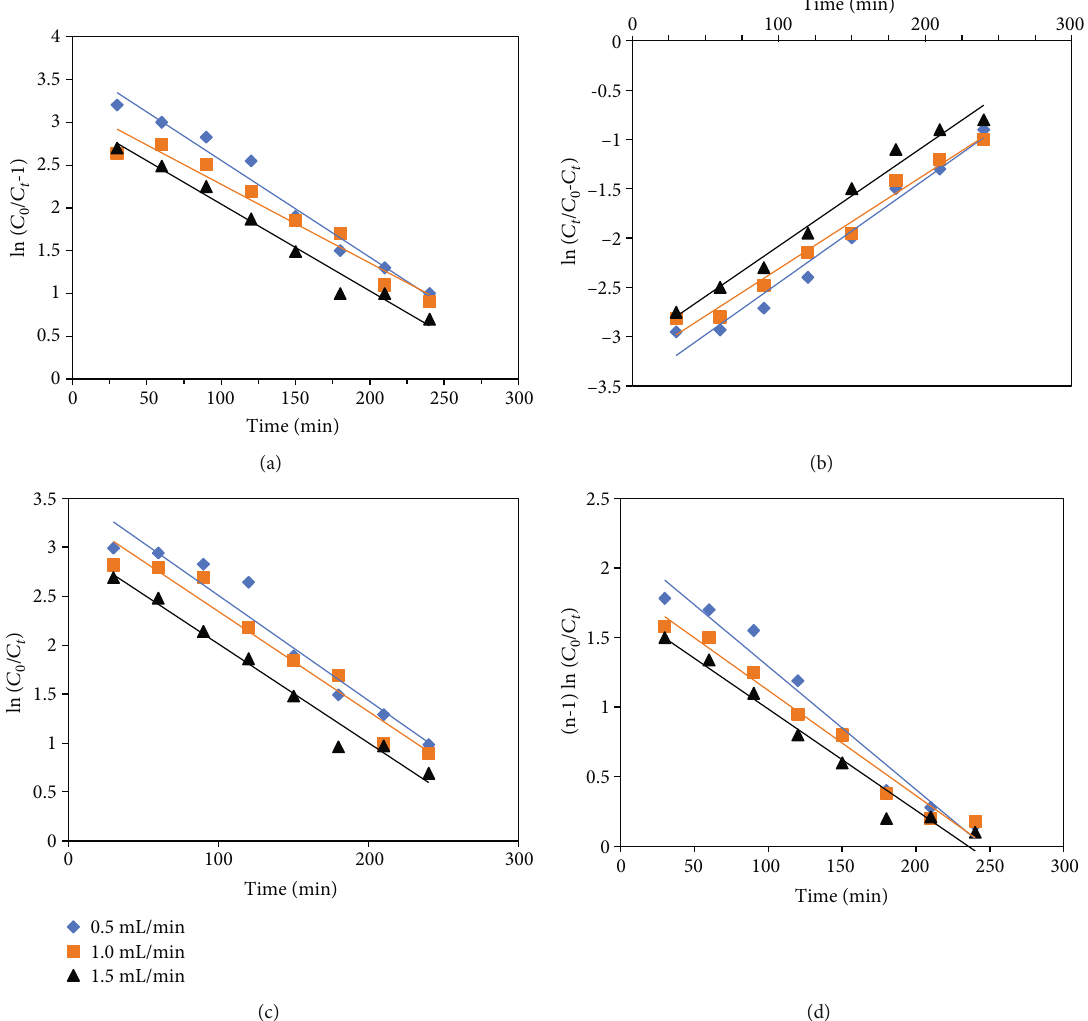
Figure 23: Breakthrough curves for (a) Thomas model, (b) Yoon-Nelson model, (c) Bohart-Adam model, and (d) Clark